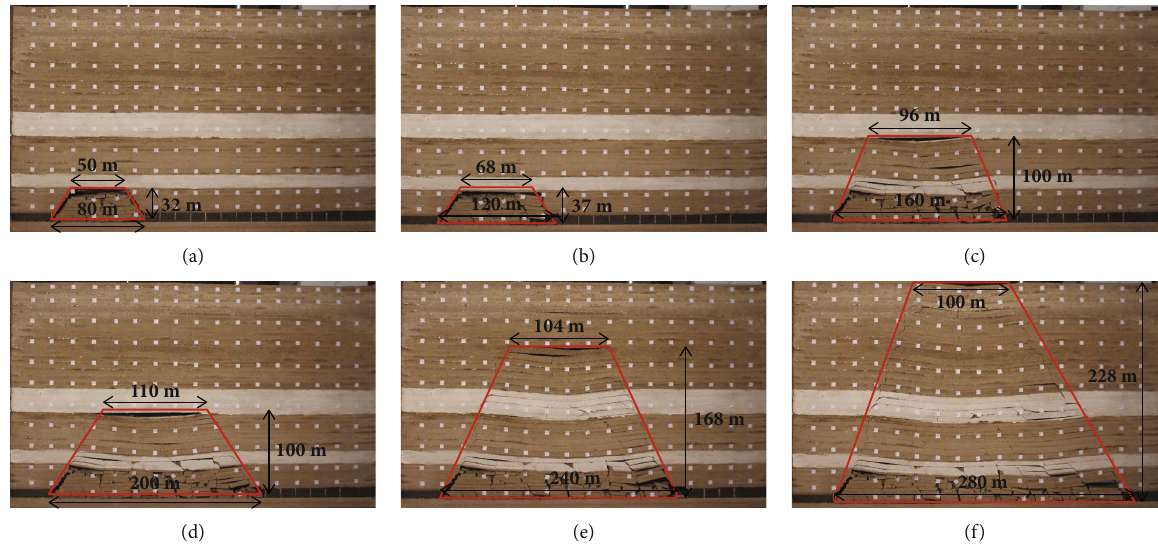
Figure 6: Evolution characteristics of overburden fracture during advancing of shallow working